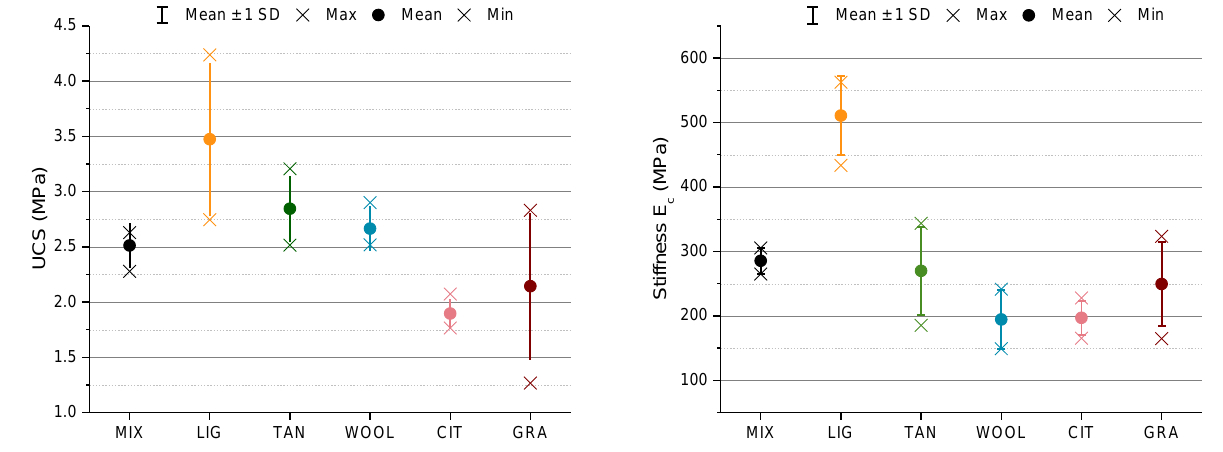
Figure 13. Unconfined compressive strength (UCS) and stiffness (chord modulus).